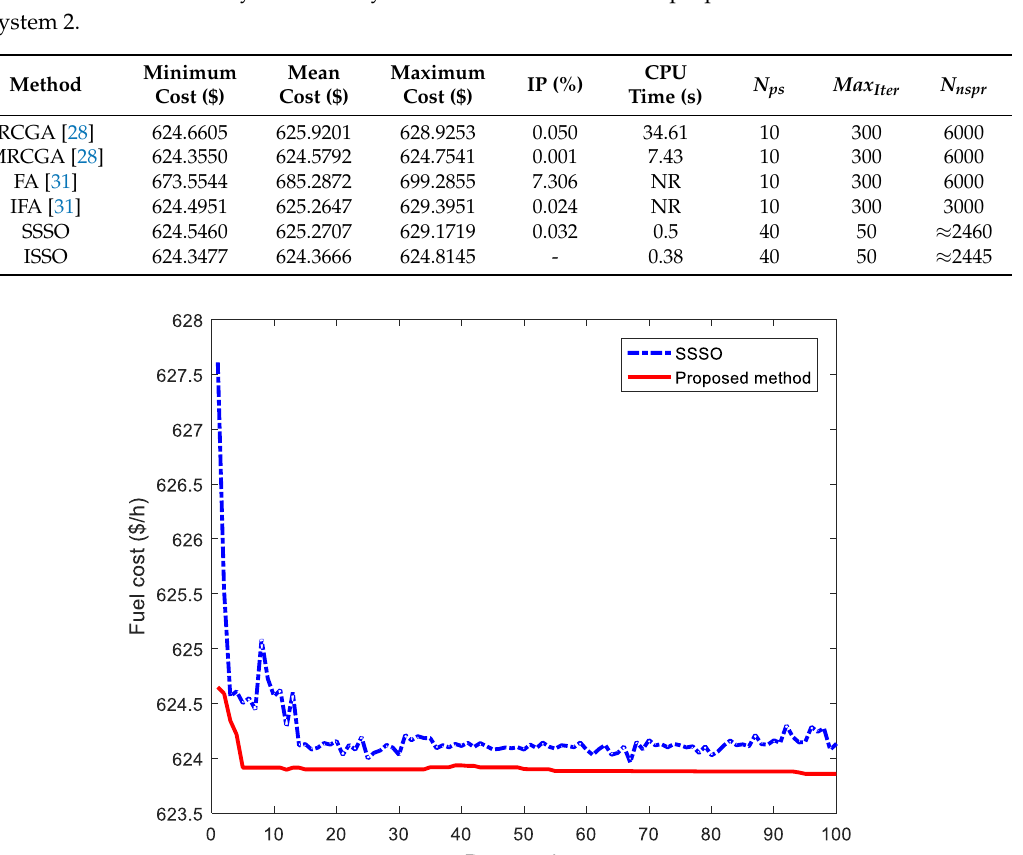
Table 5. Result summary obtained by different methods and the proposed method for case 2 of